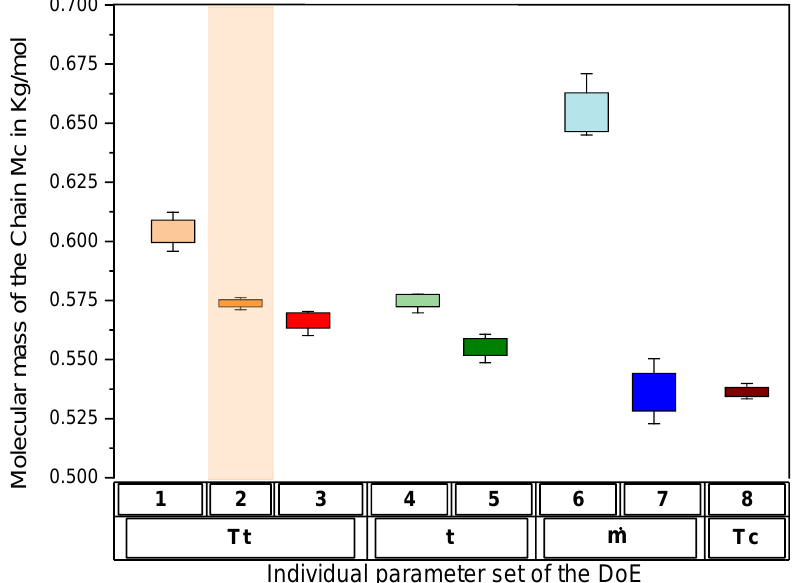
Figure 4. Molecular mass of the chain between the crosslinking points (reference in orange).